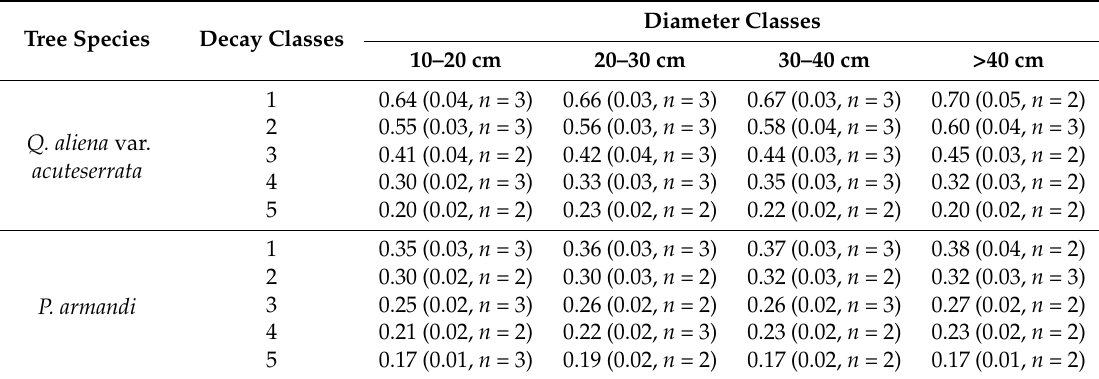
Table 4. Mean densities of CWD at five decay classes and four diameter classes in Q. aliena var. acuteserrata and P. armandi (g · cm − 3